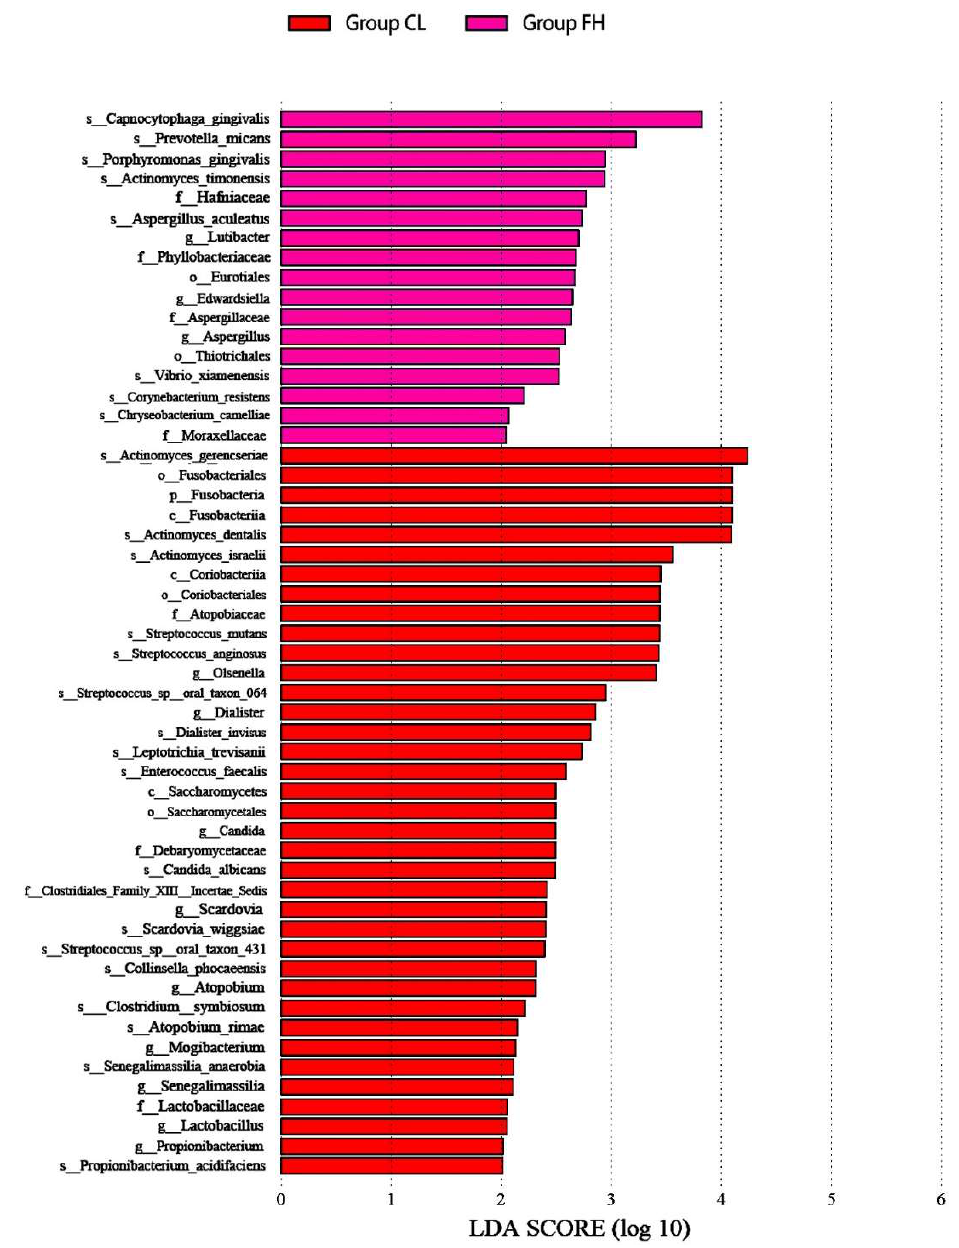
Figure 2. Relative abundance of phyla and species that were significantly higher in the FH and CL groups compared with the three other groups in LEfSe analysis (Dunn test, p < 0.05). Venn diagram was used to illustrate the shared and unique taxa for the species level among groups. A total of 2235 species were identified in our study. The overlap region S indicates the microbiome shared in all samples among the four groups, and 933 species were detected in all of the four groups. There were 84, 207, 75 and 250 unique species detected in the CL, CH, FH, and FL groups, respectively (Figure 3).